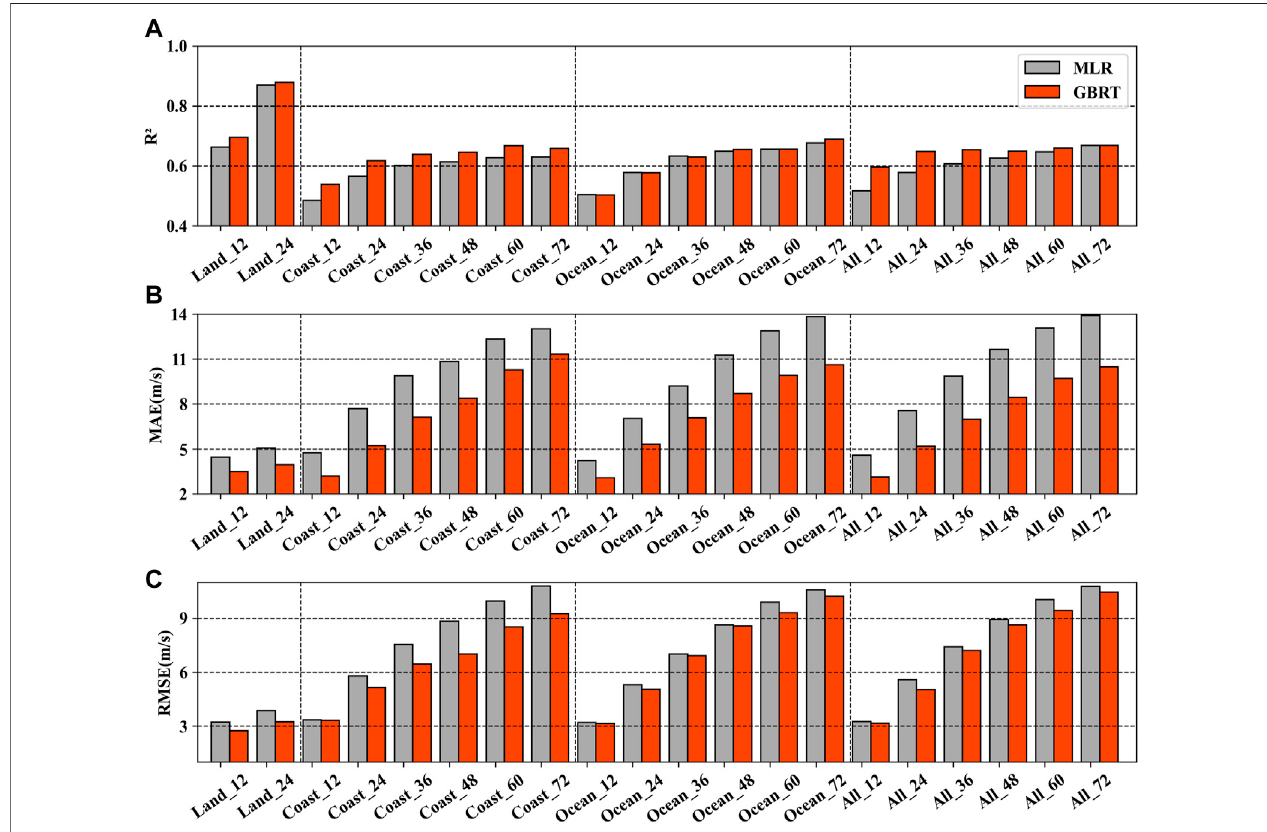
FIGURE 9 | Performance comparisons between the MLR model and GBRT model in terms of (A) R 2 , (B) MAE, and (C) RMSE for the TCs intensity change prediction based on the JTWC data from 2000 to 2015. The Land, Coast, Ocean, and All from the x-axis labels refer to TCs over land, near the coast, over the open ocean, and all TC samples,